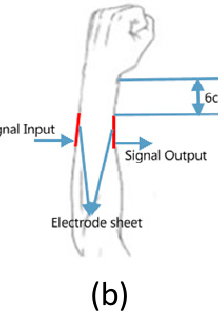
Figure 3. ( a ) Electrodes and plastic clip; and ( b ) measurement location.